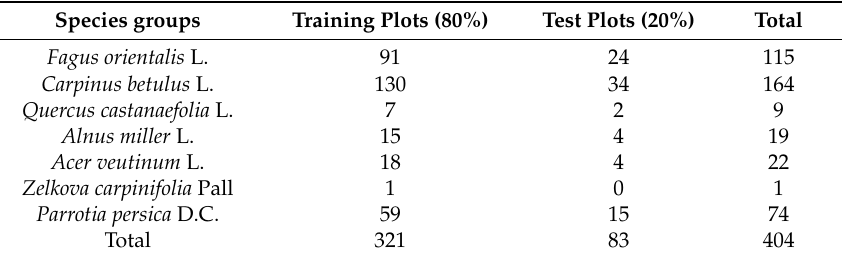
Table 6. Number of train and test plots in each class. Species groups Training Plots (80%) Test Plots (20%)